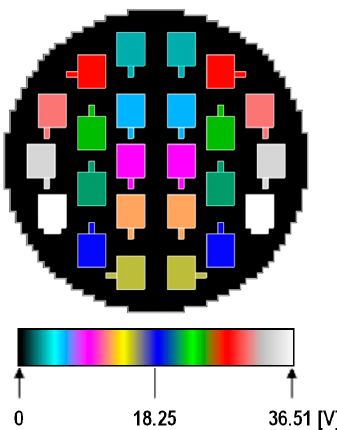
Figure 30. Luminance distribution at 80 mA of driving current and at an ambient temperature of 25 °C: ( a ) Results as presented by the software of the luminance measurement camera, ( b ) luminance distribution estimated from the simulated radiance map.